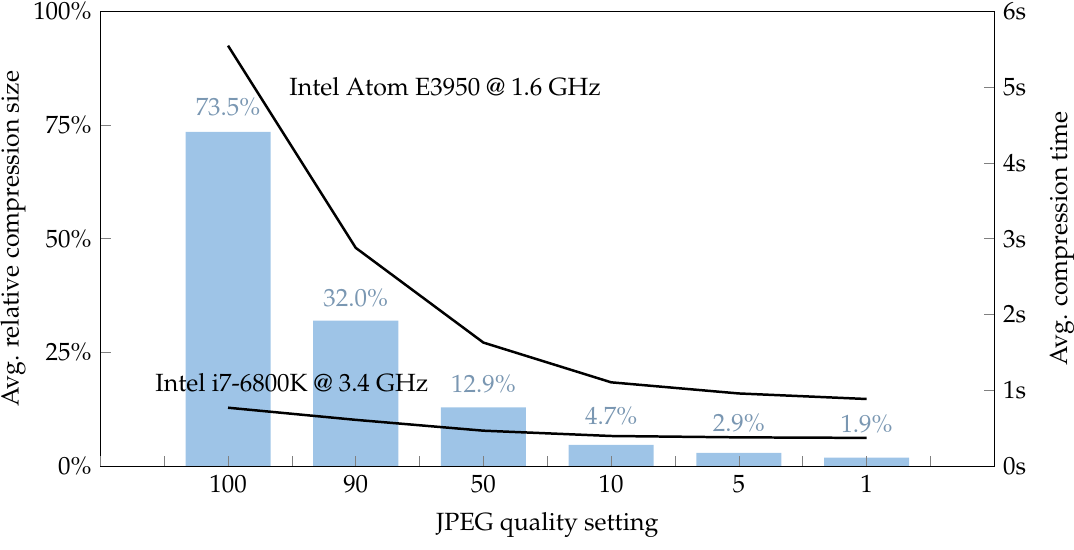
Figure 5. Compression performance of libjpeg library, version 9b, depending on the JPEG quality setting. Values show average single-thread compression time and relative compression size of a 16 MPix (4864 × 3232 pixels) 12-bit aerial image. Comparison of processing times for an Intel i7-6800K desktop CPU and an embedded System with an Intel Atom E3950 CPU.